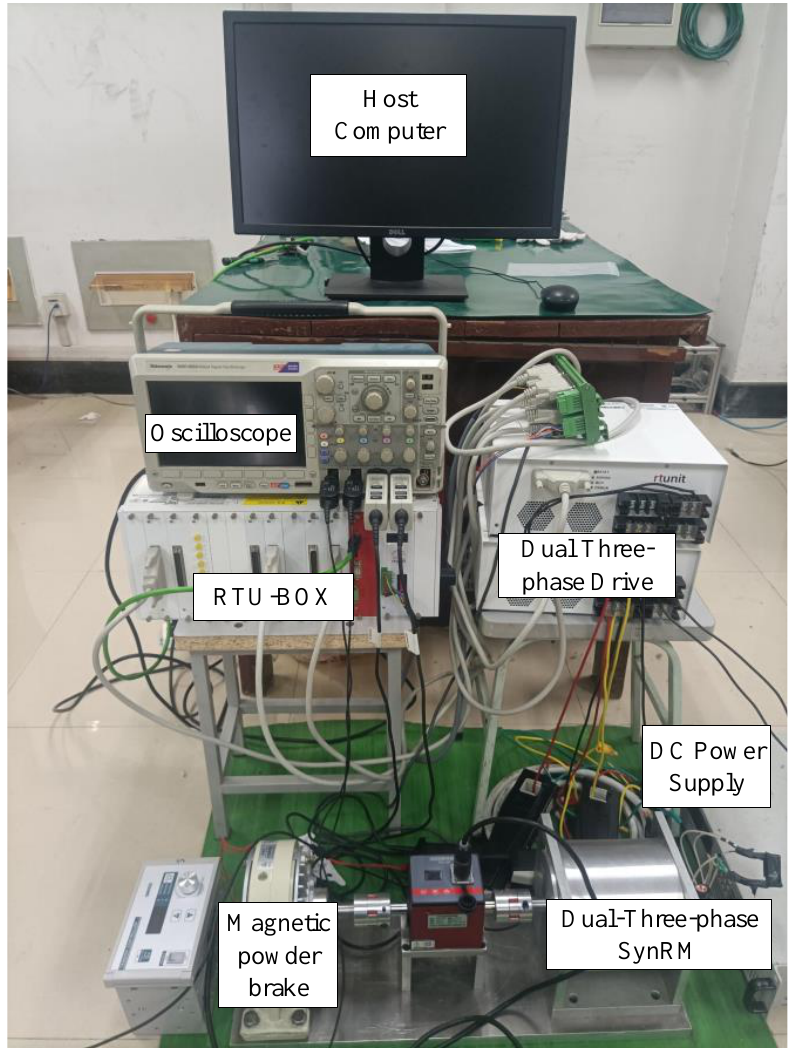
Figure 20. DTP – SynRM experimental platform. Figure 20. DTP–SynRM experimental